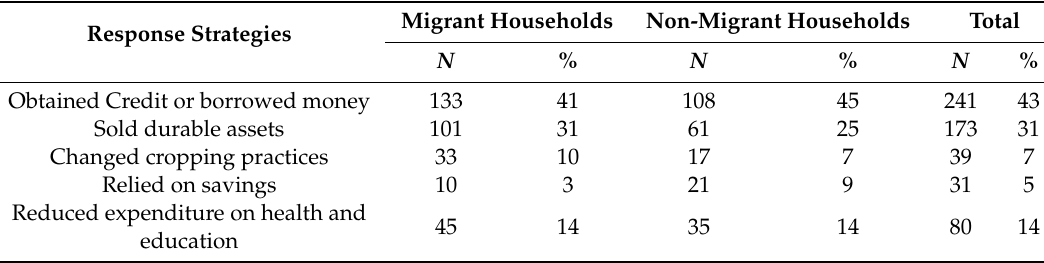
Table 6. Response strategies taken by Aila a ff ected people. Response